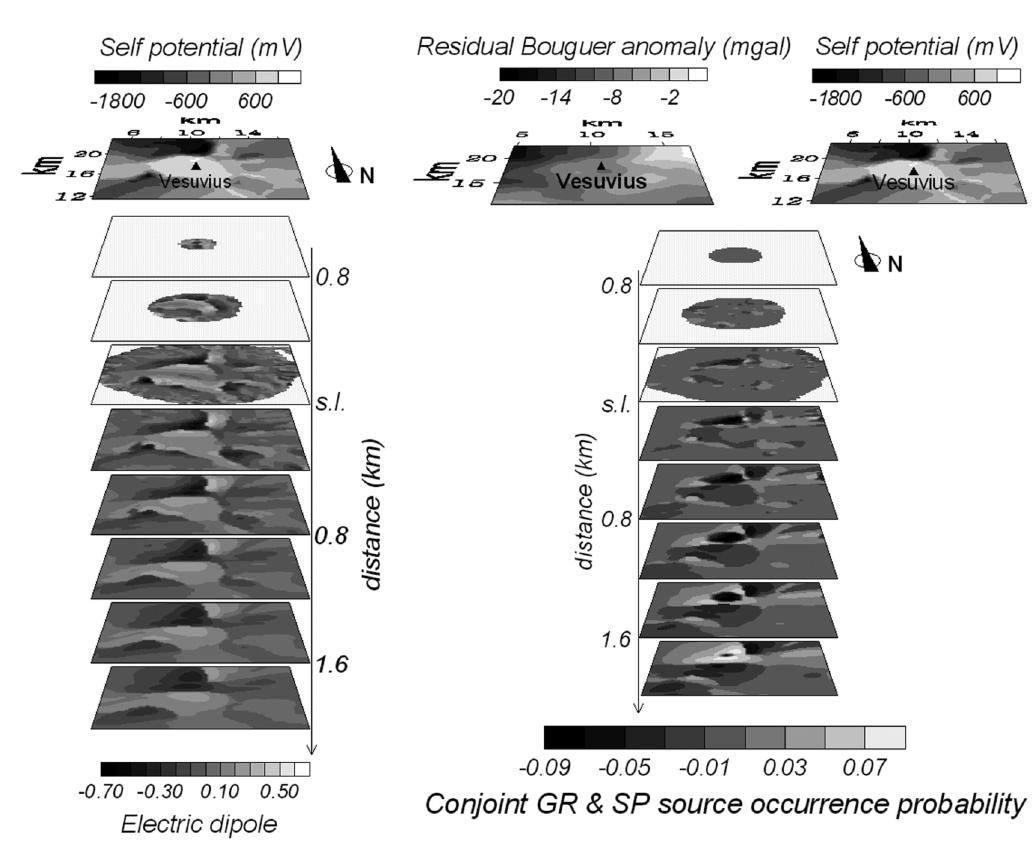
Fig. 7. The Mt. Vesuvius case-history. The self-potential dipole source probability tomography (redrawn after Di Maio et al ., 1998). The top slice is the reference SP survey map. The following tomographic column refers to the depth range from 0.8 km a.s.l. to 2 km b.s.l. with a slicing step of 0.4 km. Fig. 8. The Mt. Vesuvius case-history. The integrated gravity and self-potential dipolar source probability to- mography. The top slices are the reference GR and SP anomaly survey maps, already shown in fig.6 and fig.7, respectively. The following tomographic column refers to the depth range from 0.8 km a.s.l. to 2 km b.s.l. with a slicing step of 0.4